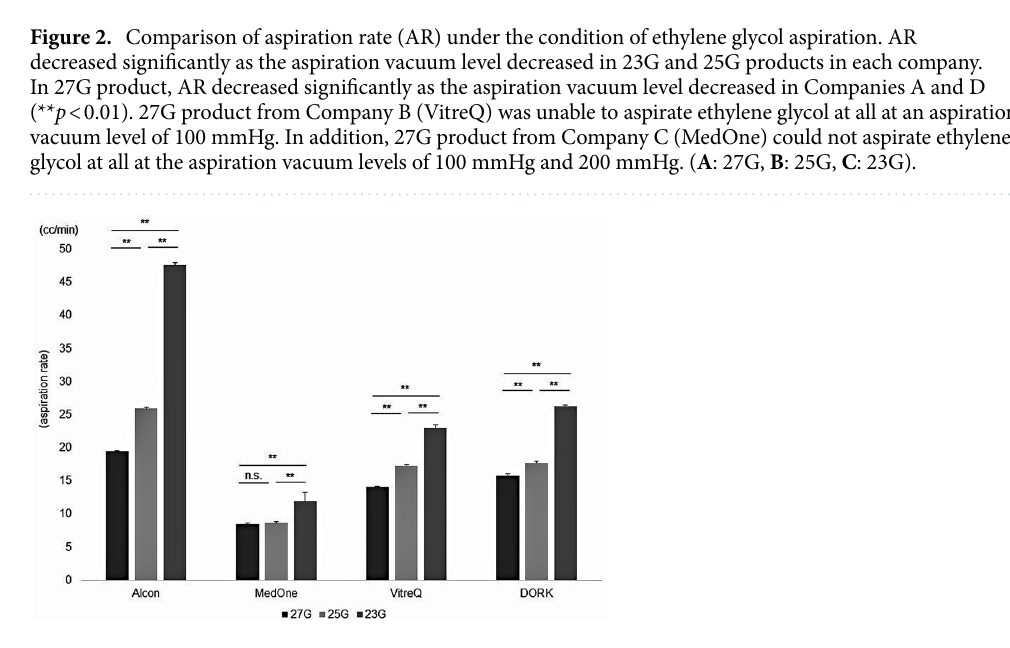
Figure 3. Comparison of aspiration rate (AR) between product gauges of each company. Except for the results of the comparison between the 27-gauge and 25-gauge products from Company B (MedOne), smaller gauge number resulted in significantly higher AR (** p < 0.01).